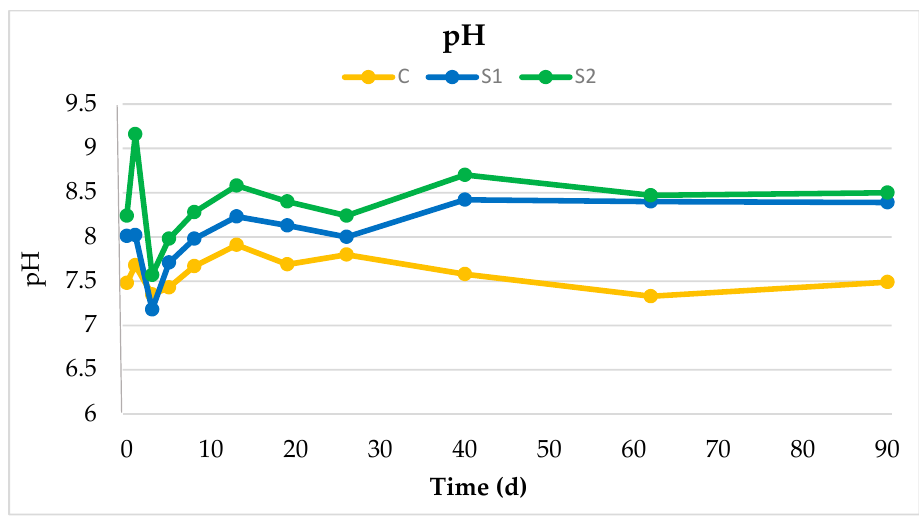
Figure 2. Evolution of pH during composting.